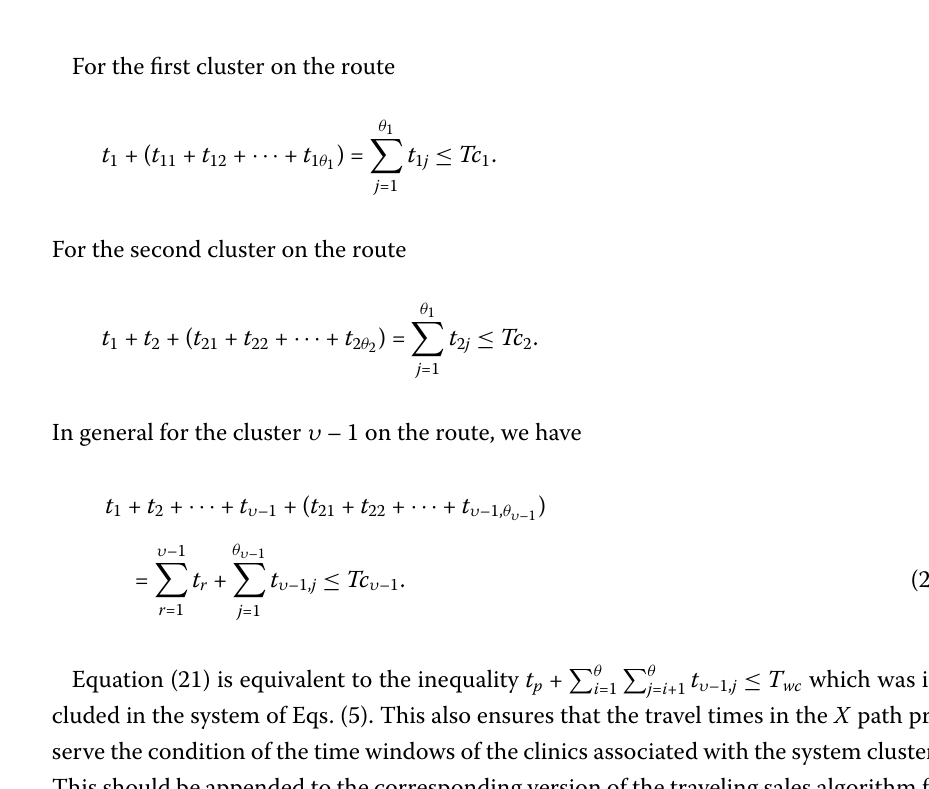
Algorithm 2 (Calculation of transport